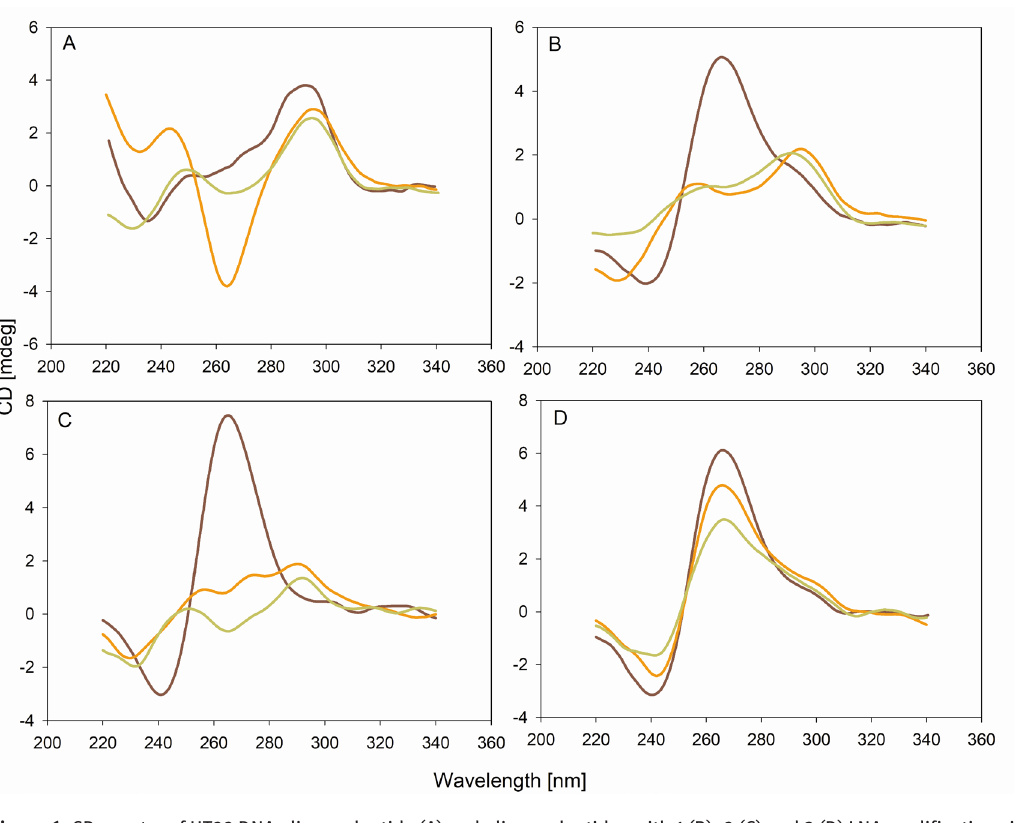
Figure 6: CD spectra of HT22 DNA oligonucleotide (A) and oligonucleotides with 1 (B), 2 (C) and 3 (D) LNA modifications in various cationic conditions: brown – potassium, orange – sodium, yellow – ammonium. Conditions: 10 mM Tris-HCl (pH=8.0), 100 mM salt, 2 µM DNA.